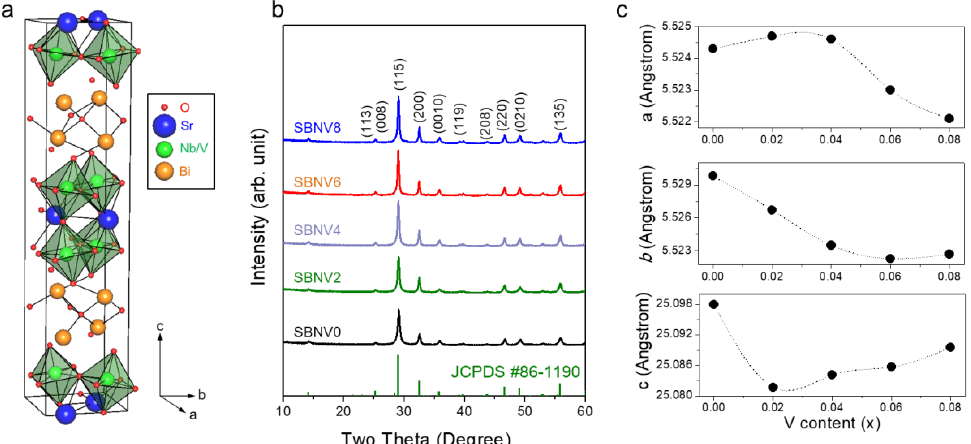
Figure 1. ( a ) Crystal structure of a layered perovskite compound of SrBi 2 Nb 2 O 9 . ( b ) X-ray di ff raction patterns and ( c ) lattice parameter variation of SrBi 2 Nb 2 − x V x O 9 compounds (x = 0, 0.02, 0.04, 0.06, and 0.08, denoted as SBNV0, SBNV02, SBNV04, SBNV06, and SBNV08,